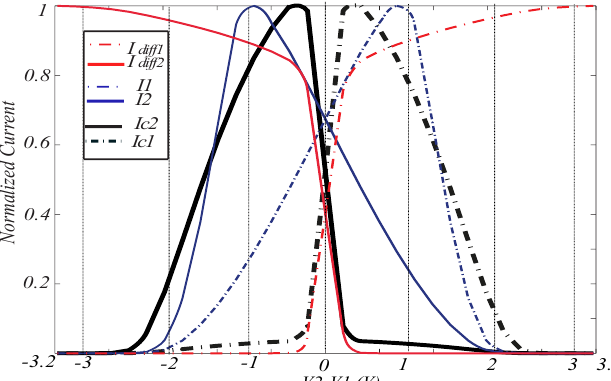
Figure 6. Simulation of the currents Ic1 and Ic2 in the circuits shown in Figure 5 as black curves. The currents in the circuit in Figure 1 and a differential pair with resistive load are also presented for comparison. The dashed curves are the currents through the right leg of the circuit, and the solid curves are the currents in left leg. All the curves are normalized by their maximum